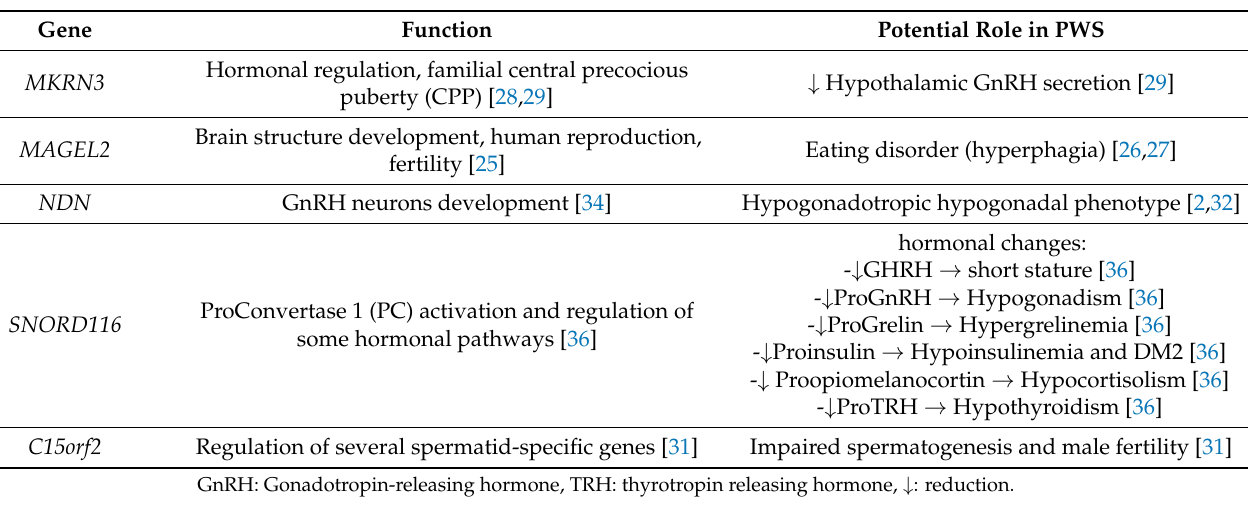
Table 1. Genes, their function, and their potential role in